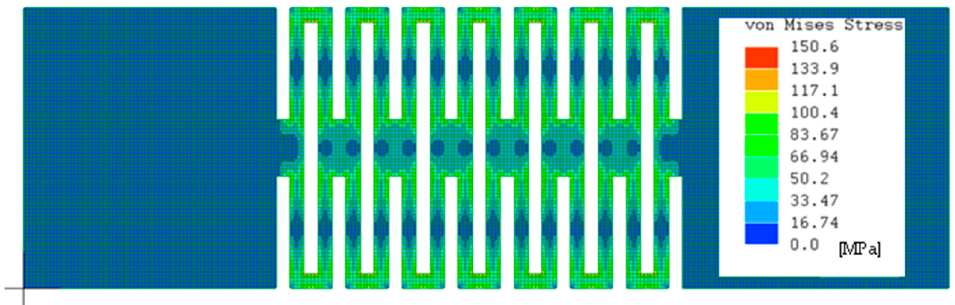
Figure 8. Von Mises stress distribution by FEM analysis with 2.5 mm grid elements (F-7).